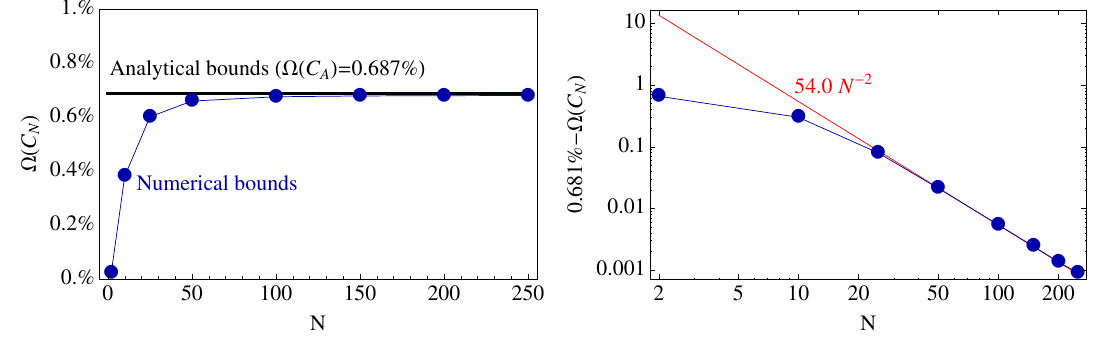
Figure 5 . Solid angle Ω( C N ) for different N